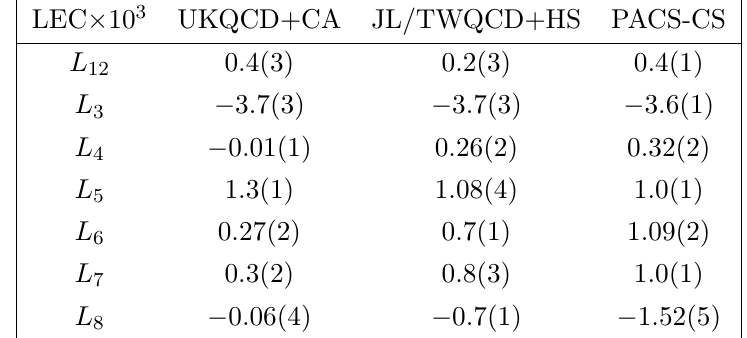
Table 4 . Values of the LECs obtained from di(cid:11)erent m s = k (cid:12)ts as described in the main text. Uncertainties are obtained from the minimization with the MINUIT